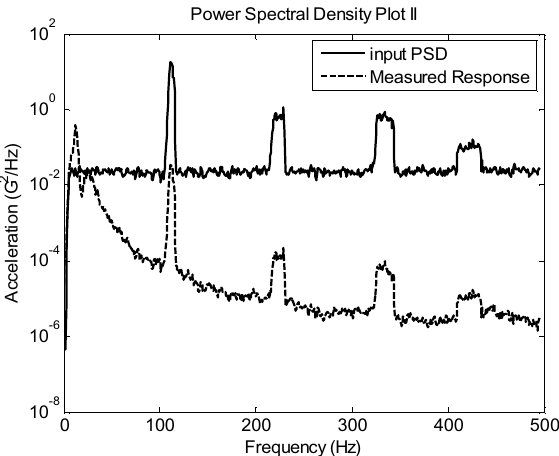
Fig. 17. PSD plot for vibration isolation system II.